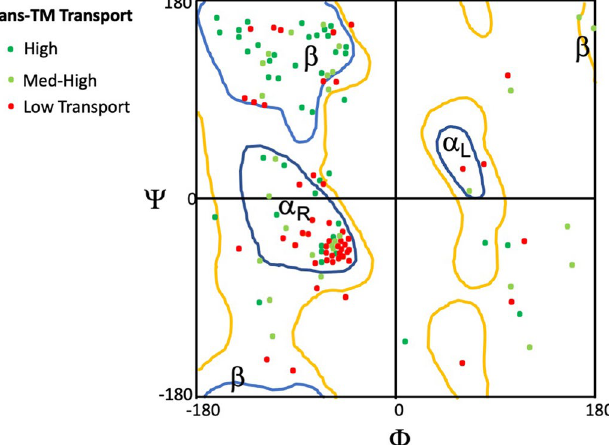
Figure 2. Ramachandran plot for 12-mer peptides expressed by trans-TM peptide phage with differing rates of transport across the membrane (Table 1). The plot predicts the orientation of the amino acids in a peptide backbone based on their side chains. Orientations consistent with β-string (β), right-handed α-coil (α R ) and left-handed α-coil (α L ) structures are outlined. When peptides from different trans-TM transport categories are plotted, the peptides with the highest rates (green) show a strong tendency to fall into the area consistent with β-string formation. The amino acids of those with the lowest rates (red) cluster in the area most consistent with right-handed α-coil